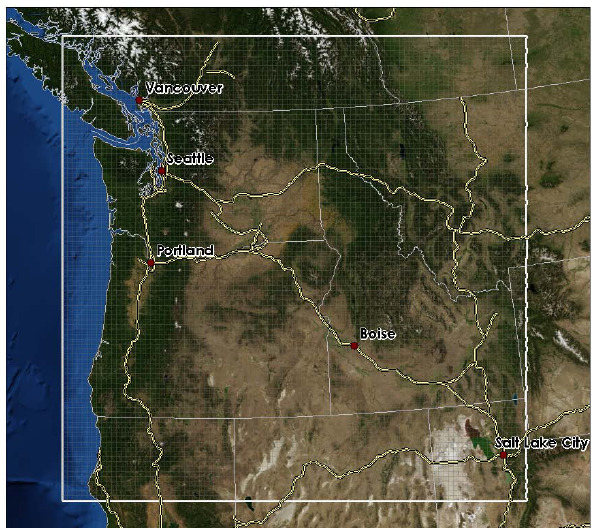
Fig. 1. The AIRPACT-3 domain Satellite imagery of the AIRPACT- 3 domain is shown with interstate freeways as yellow lines and large cities as red